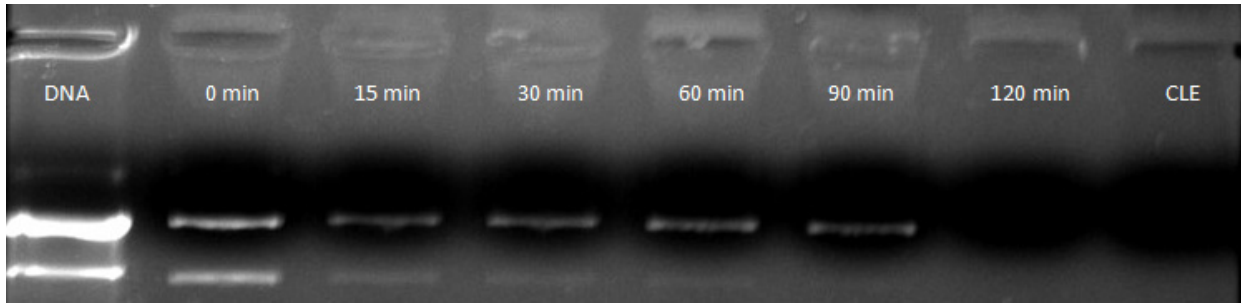
(2.30 pDNA/CLN 1 1